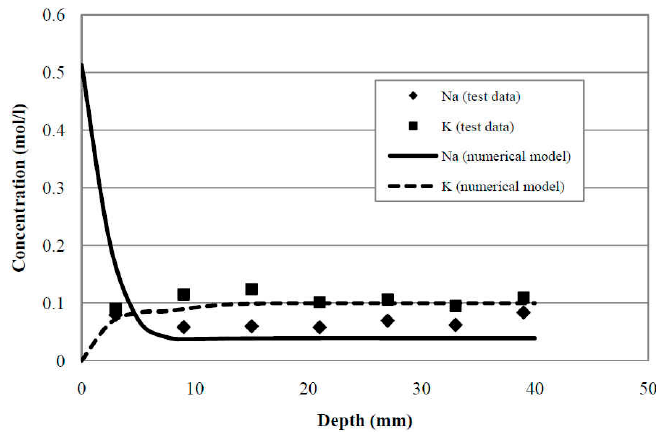
Figure 6. Comparison of test and numerical results. The specimen was exposed for 15 days and 30 days [48].